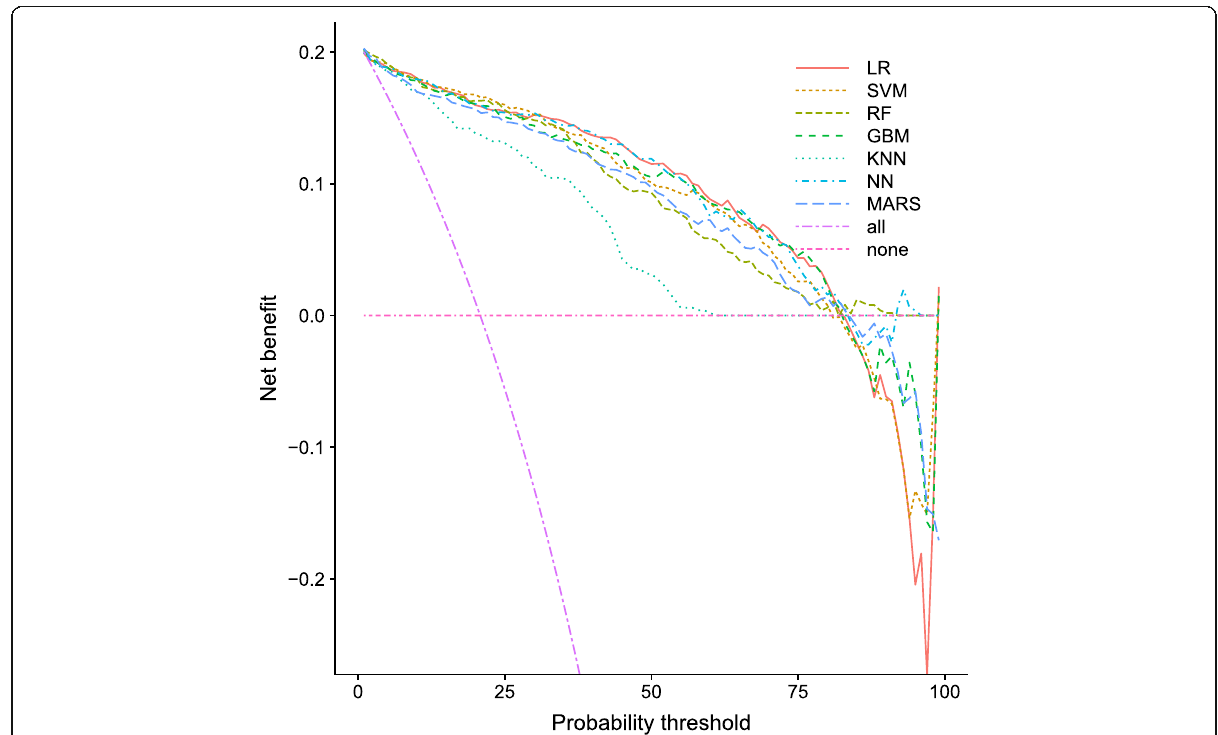
Fig. 2 Decision curve analysis obtained using external validation dataset for prediction models. The graph gives the expected net benefit per patient relative to treat all patients as type 2 diabetes. The unit is the benefit associated with one patient with type 1 diabetes receiving the correct treatment. ‘ all ’ : assume all patients have type 1 diabetes. ‘ none ’ : assume no patients have type 1